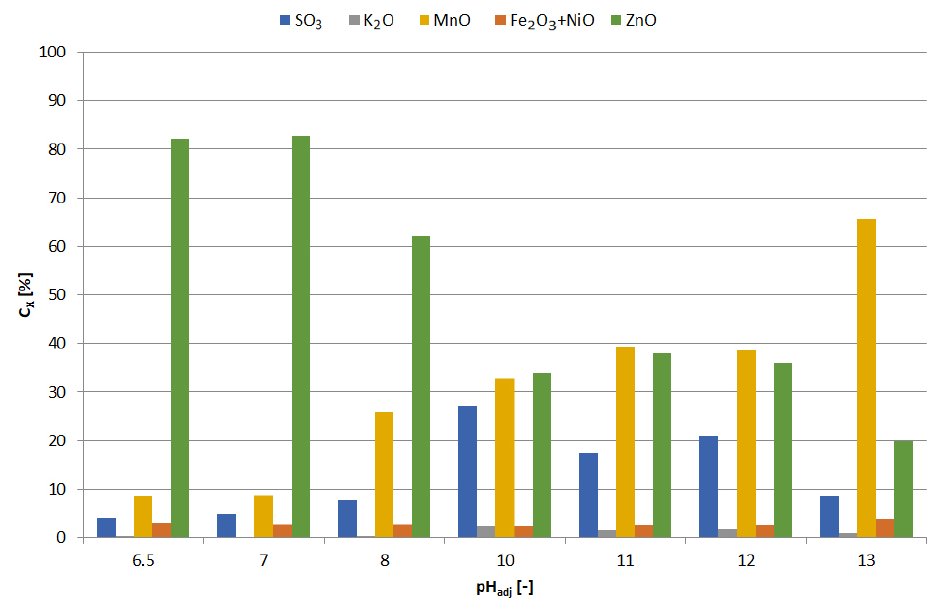
Figure 18. Effect of adjusted pH (pH adj ) on chemical composition of precipitates as a result of precipitation by using NaOH from non-selective leaching solution.